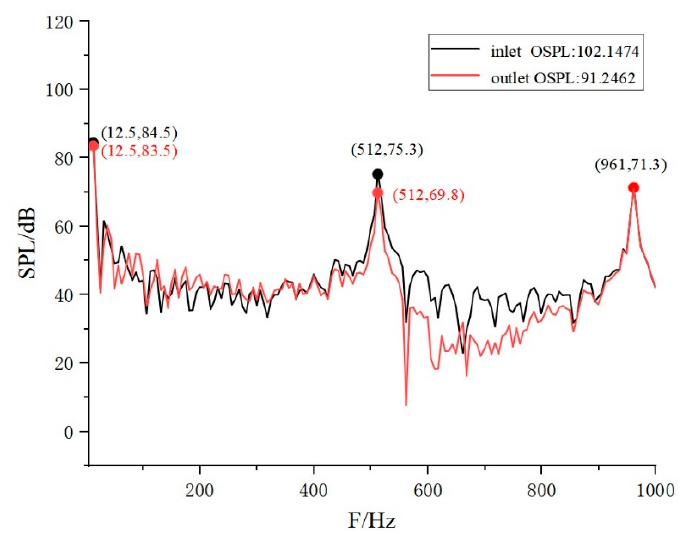
Figure 28. Spectrum diagram with 3.5 times flow area.